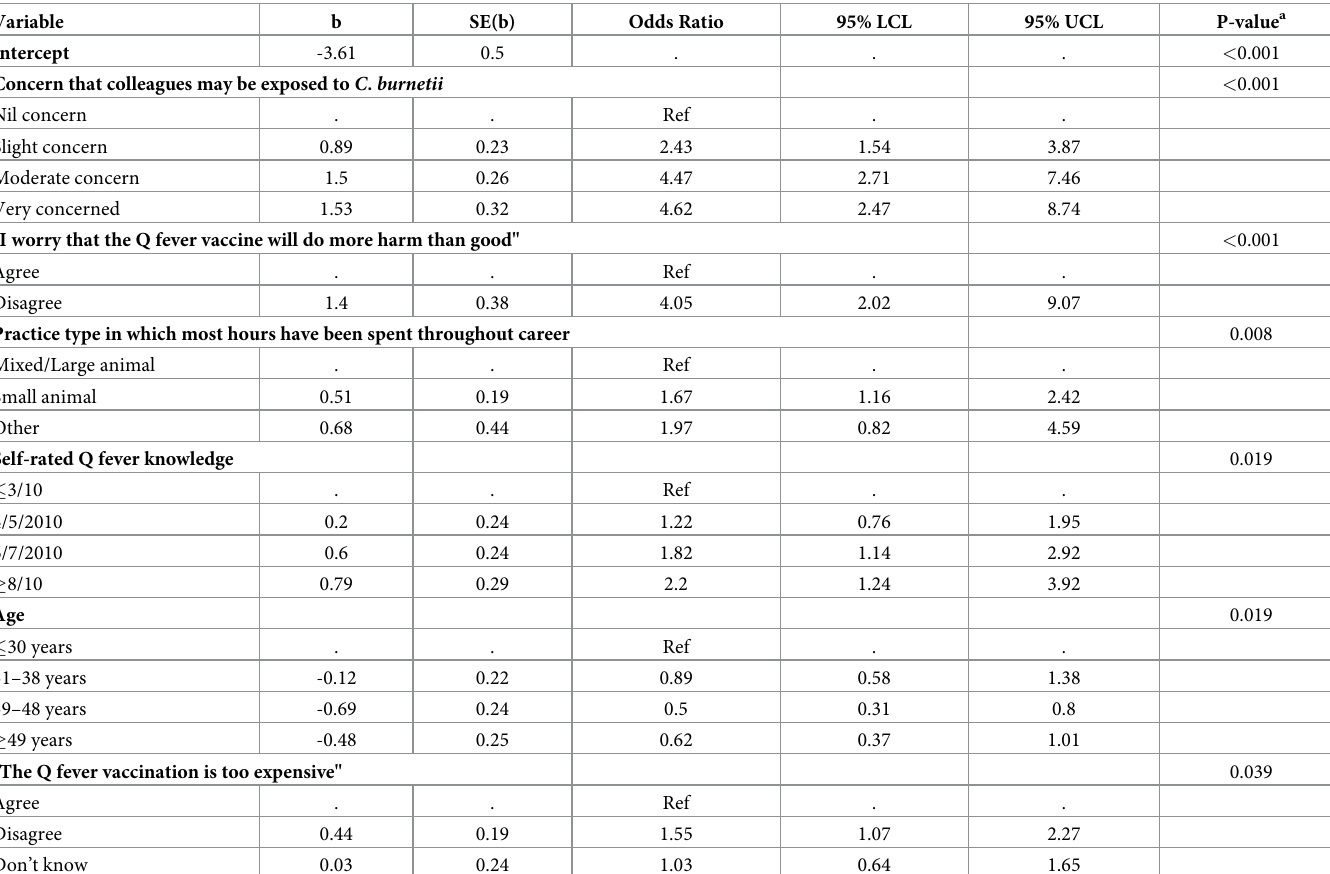
Table 1. Final multivariable model parameter estimates and odds ratios of factors associated with a willingness to recommend Q fever vaccination among veterinar- ians surveyed in Australia in